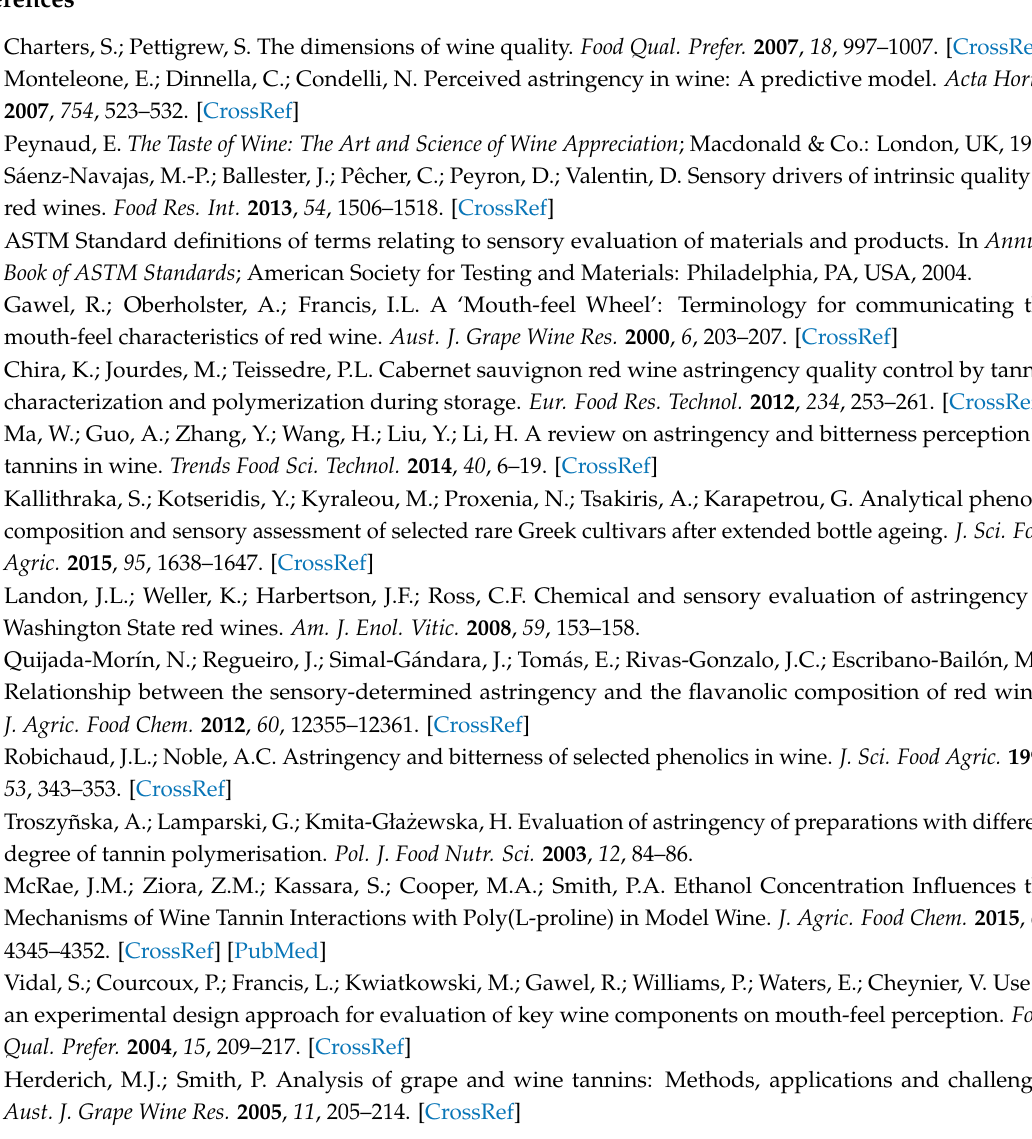
Table S1: Phenolic composition of the